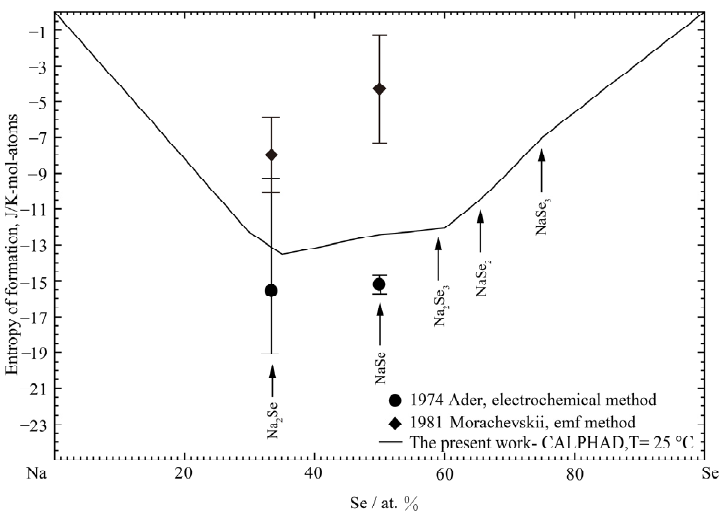
Figure 8. The calculated entropy of formation of the Na-Se binary system at 25 °C compared with the experimental data [38,71].